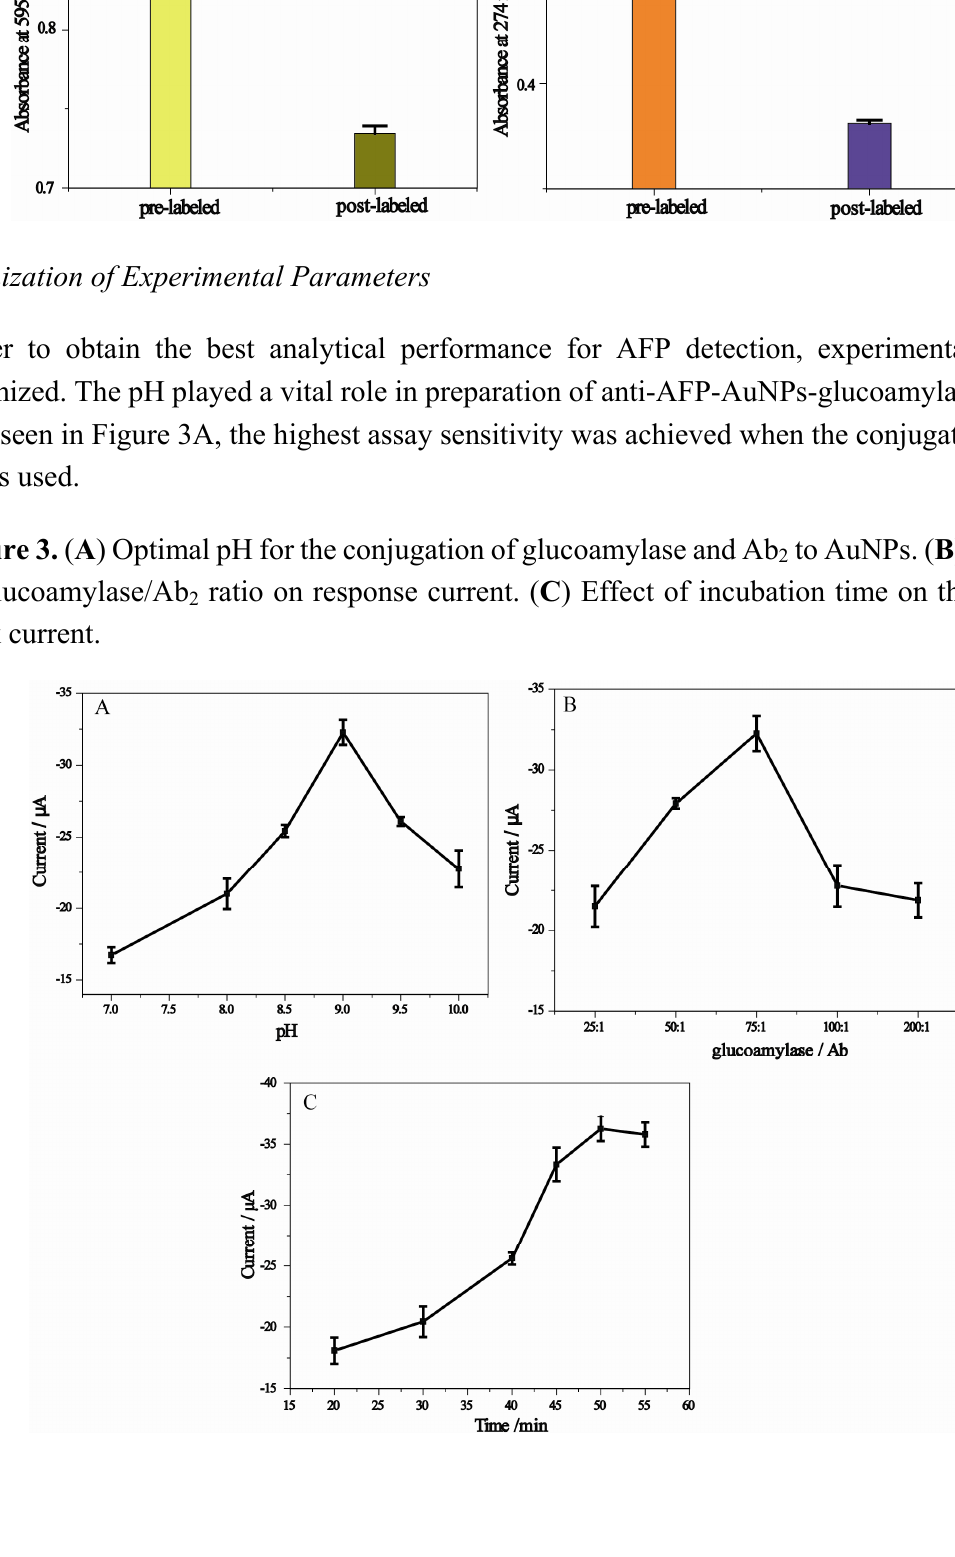
in pre-labeled and post-labeled Ab solutions. 2 2